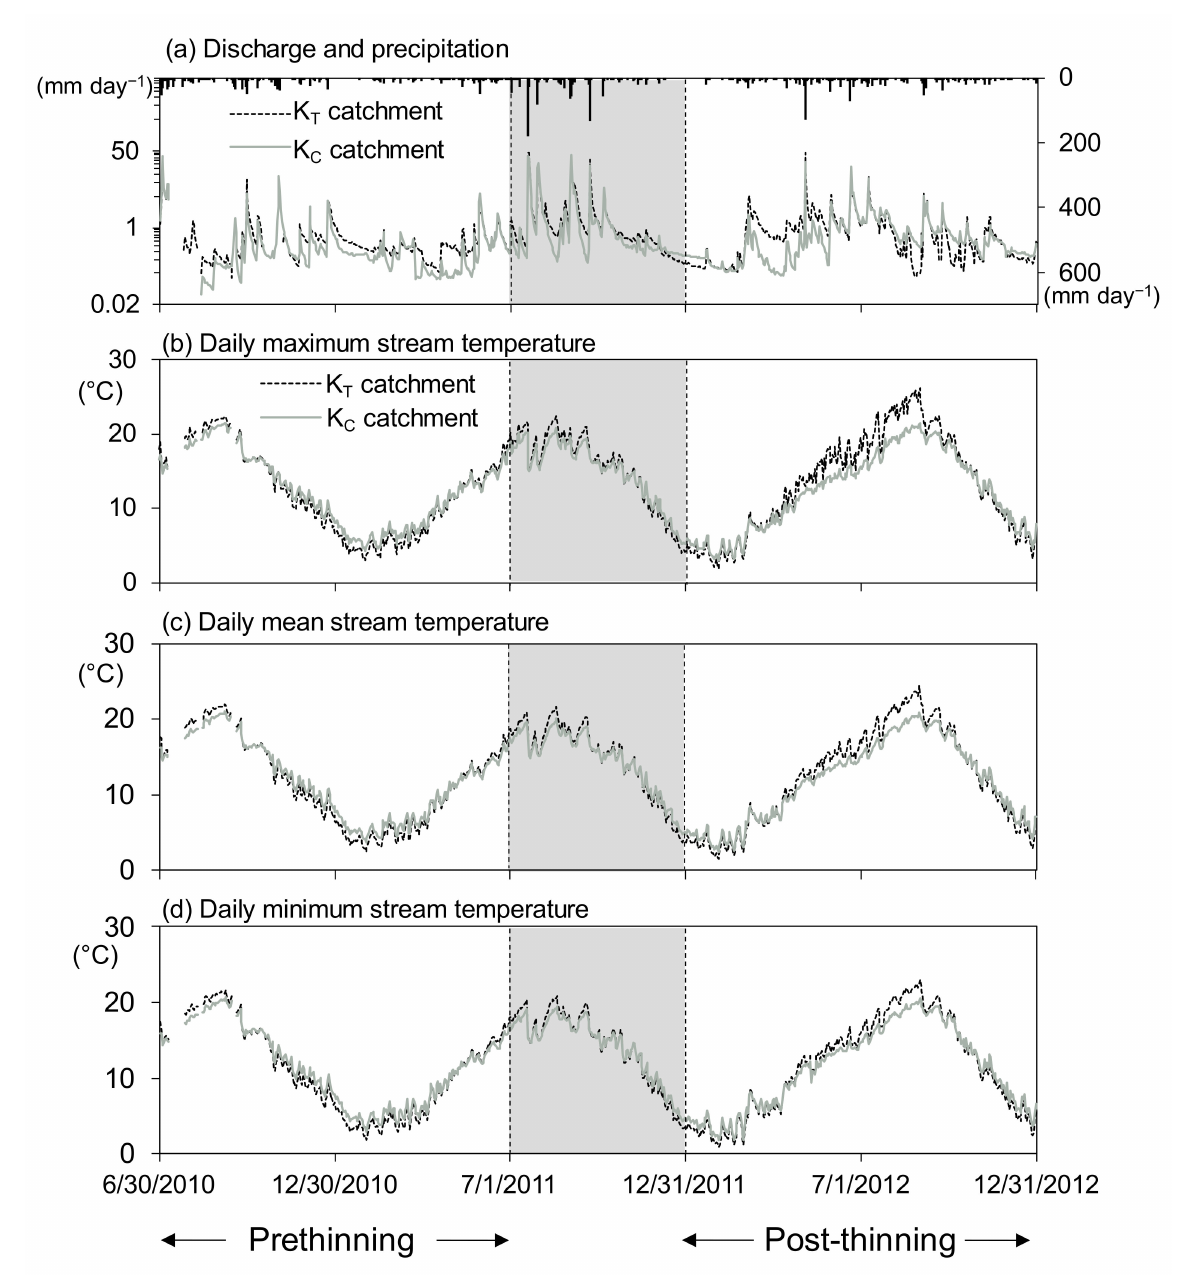
Figure 4. ( a ) Daily stream discharge and total daily precipitation, ( b ) daily maximum stream temperatures, ( c ) daily mean stream temperatures, and ( d ) daily minimum stream temperatures at the K T and K C catchments. Shaded area indicates during thinning operation